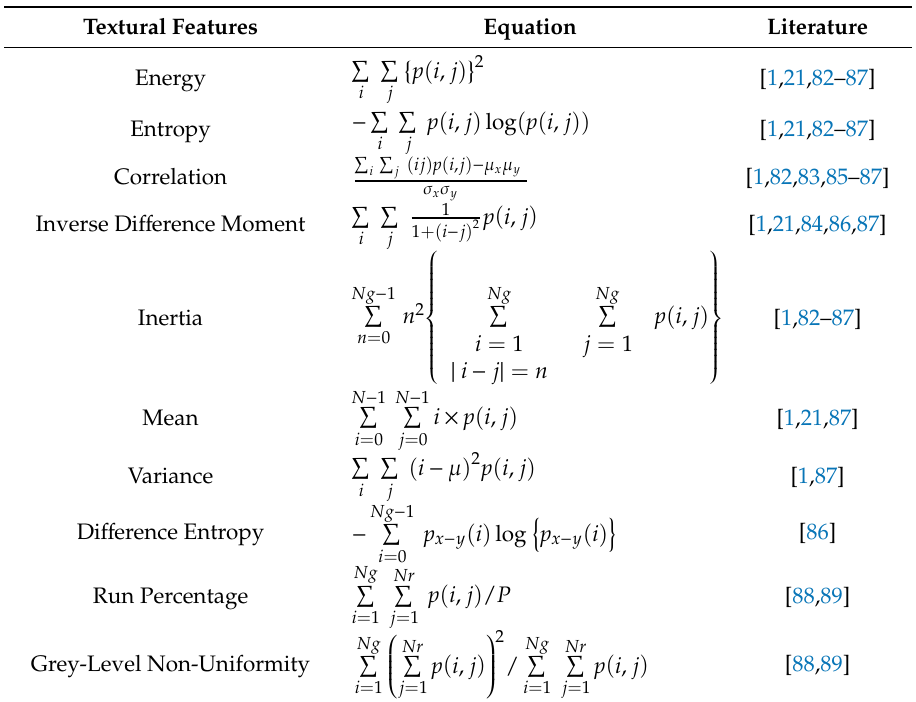
Table 2. Texture information calculation ( µ x , µ y , σ x , σ y : means and standard deviations of p x and p y , p(i,j): (i,j) th entry in a normalized gray-tone spatial-dependence matrix and in the given run length matrix, Ng: number of gray levels in the quantized image, Nr: number of run length that occur, P: number of points in the